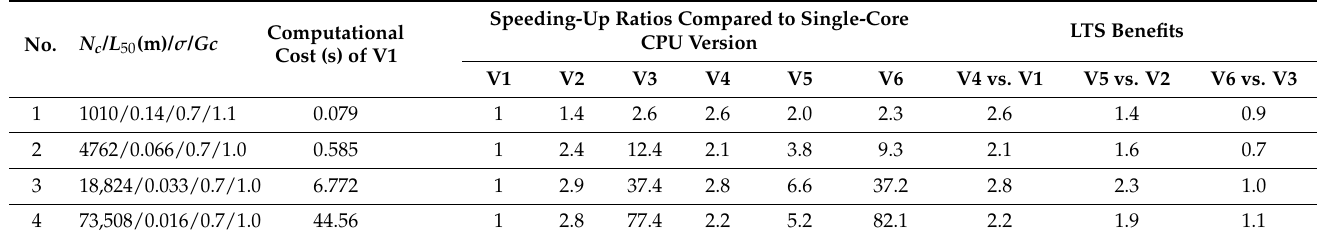
Table 2. Statistics for simulations of the idealized dam-break flows (V1-V6 refers to the six SWM versions).